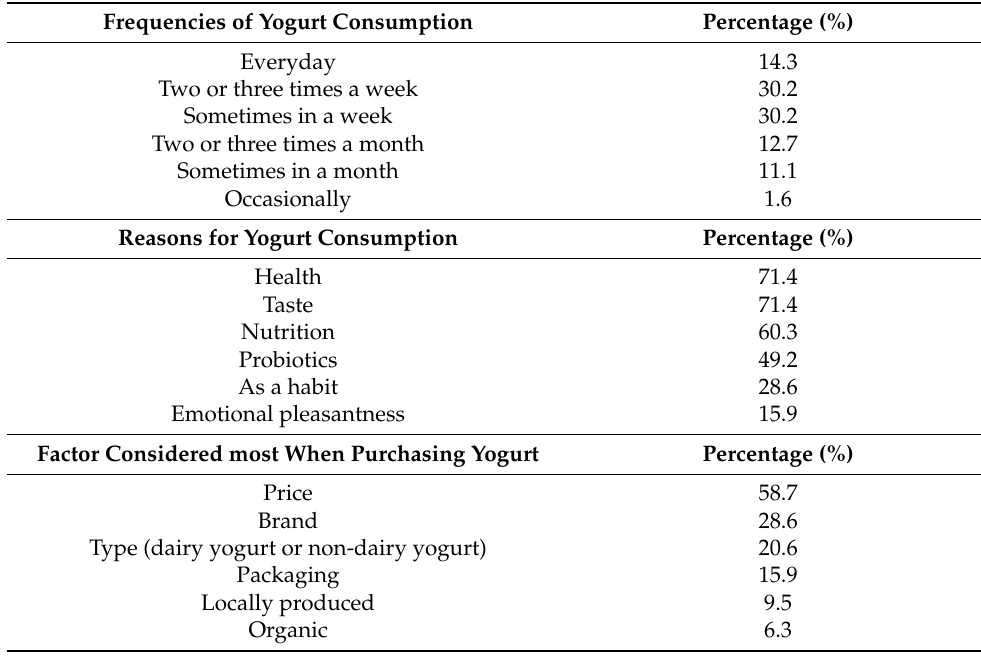
Table 4. Factors affecting consumers’ consumption of yogurts and